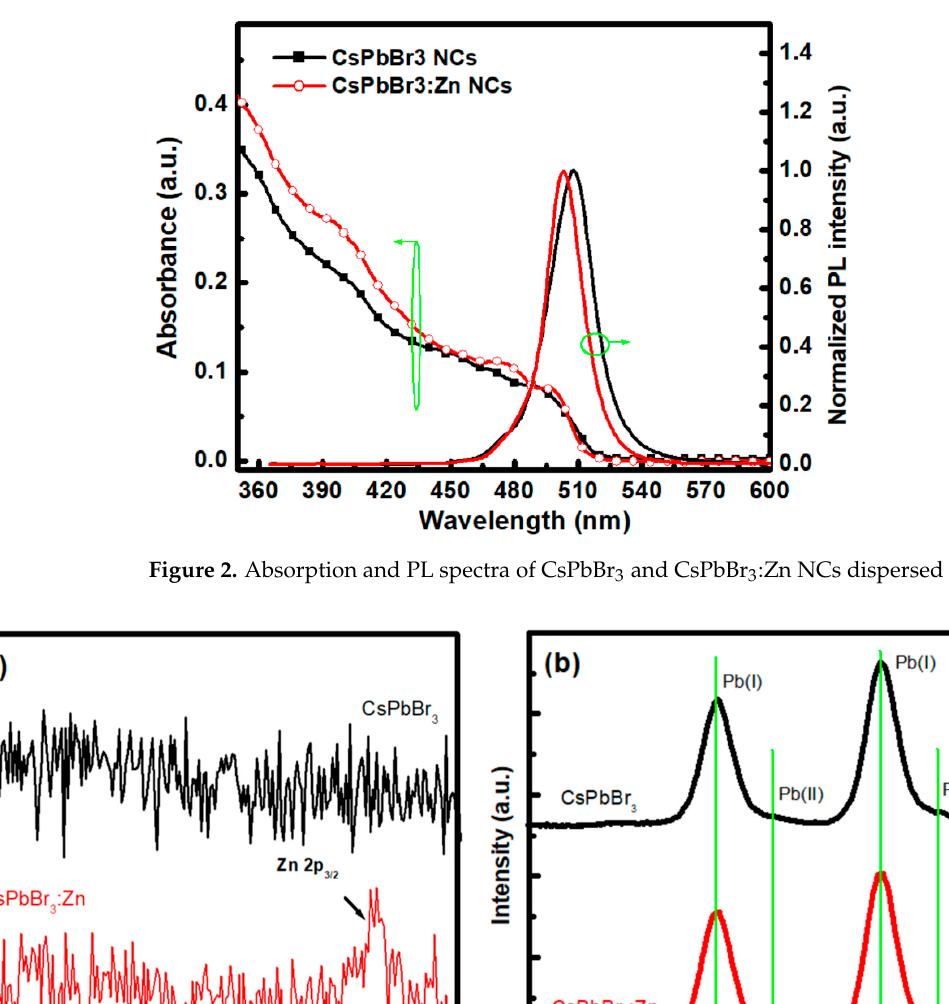
Figure 2. Absorption and PL spectra of CsPbBr 3 and CsPbBr 3 :Zn NCs dispersed in hexane.